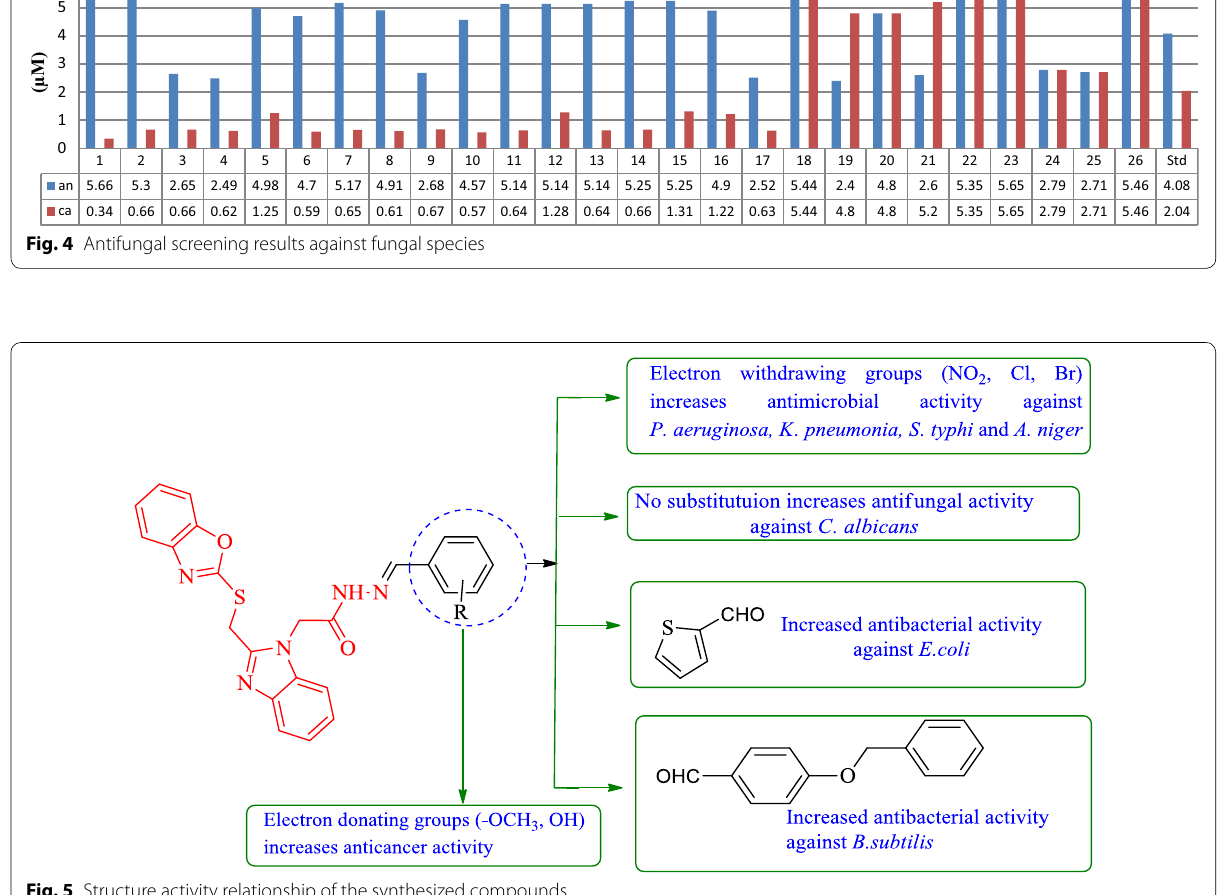
Fig. 5 Structure activity relationship of the synthesized